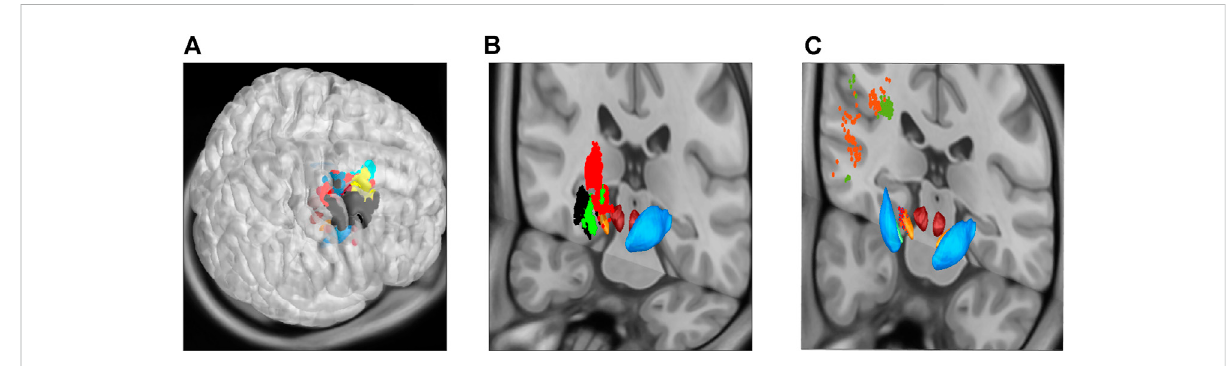
FIGURE 5 Communitydetectionusingthemodularity-indexalgorithmLeichtandNewman[57],nowprojectingthesamecommunitiesasinFigure4onto MNI space sections, showing motor cortical areas as surface projection (A) , thalamus and basal ganglia as frontal cut projection (B) and STN-MC connectionsas hyperdirect pathwayprojected onto afrontal section (C) . As intheprevious fi gure,the 12 major areas arelocated in MC(6), thalamus (1) and basal ganglia (2), as well as three communities in locations associated with the hyperdirect pathway (one in STN in light orange, two connecting STN and MC; dark orange and